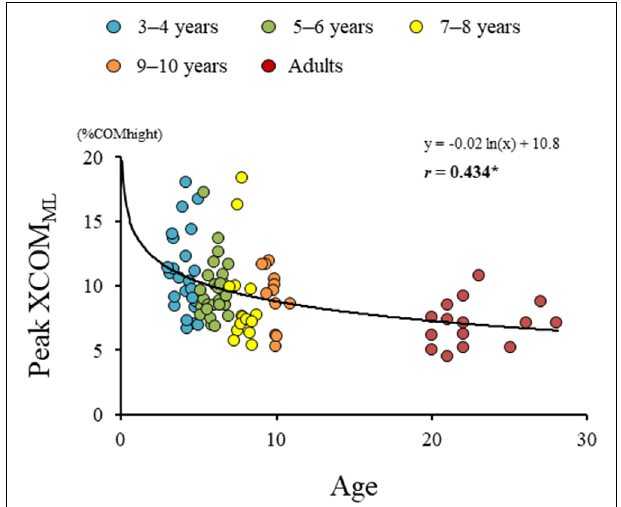
FIGURE 6 | Results of regression analysis performed for age and extrapolated center of body mass in mediolateral axis (XCOM ML ). *,Significant correlation with age, p <